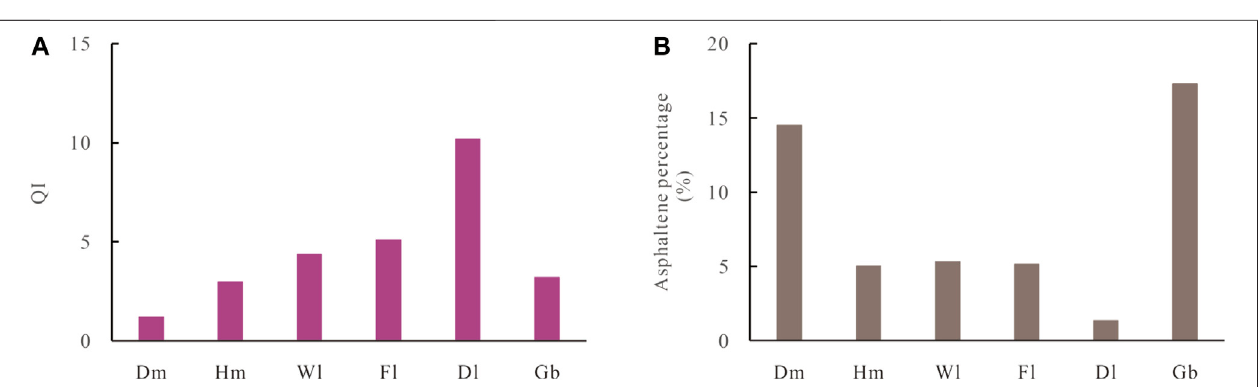
FIGURE 11 | Average QI and asphaltene percentage in shale with different lithofacies. (A) QI (Quality index, QI (cid:1) Content saturates+aromatics /Content resins+asphaltenes ). (B) Asphaltene percentage.